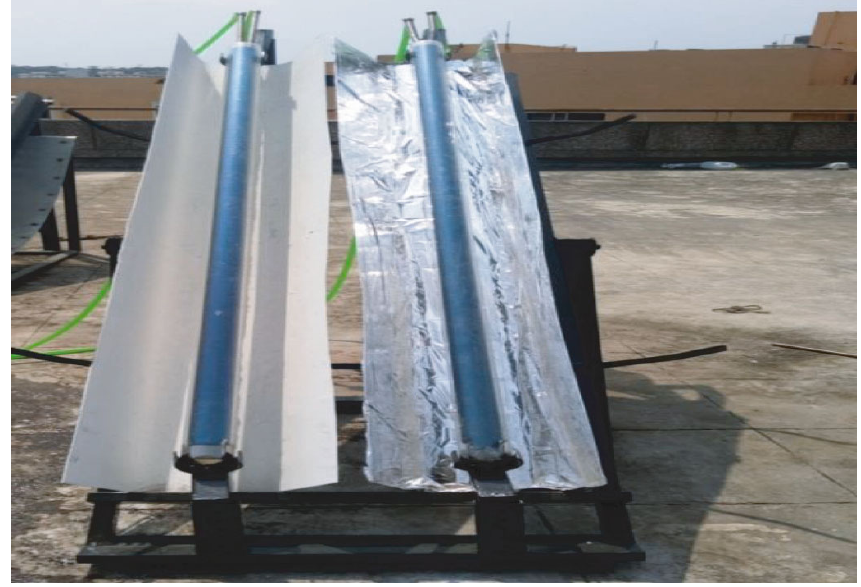
Figure 1: Experimental setup.